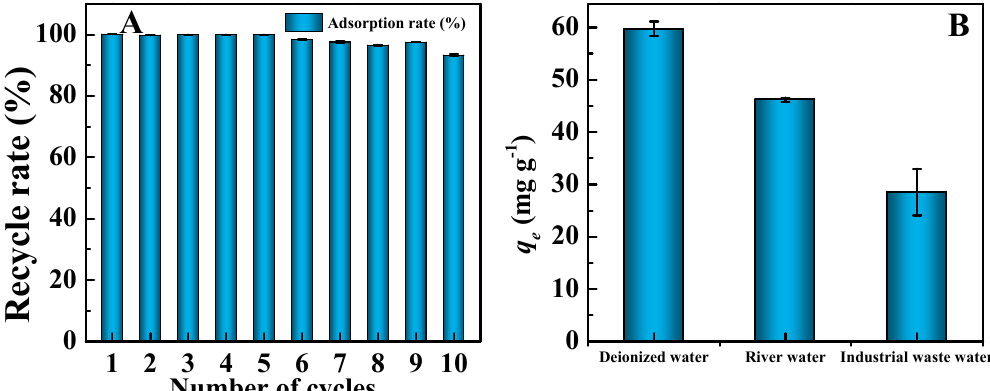
Figure 10. ( A ) Recycle rate of CPP200 for MB in successive 10 adsorption − desorption cycles ( C MB = 10 mg/L, adsorbent dosage of 50.0 mg and contact time of 90 min, T = 25 °C). ( B ) The adsorption of MB from actual water samples by CPP200 (MB concentration of 50 mg/L, adsorbent dosage of 5.0 mg and contact time of 90 min, T = 25 °C).